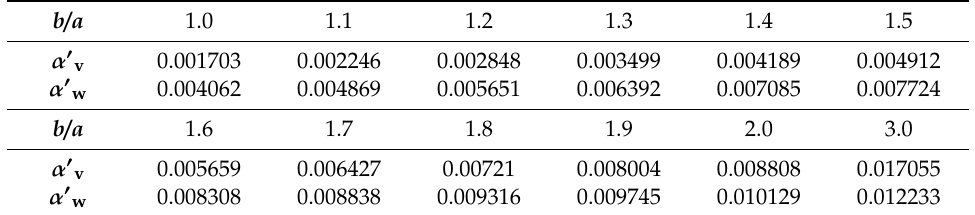
Table 1. Coe ffi cients for calculating volume change and deflection for simply supported glass